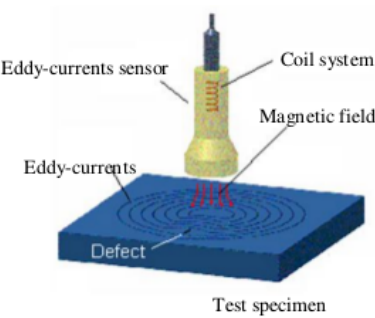
Figure 4: Schematic of the ultrasonic equipment.